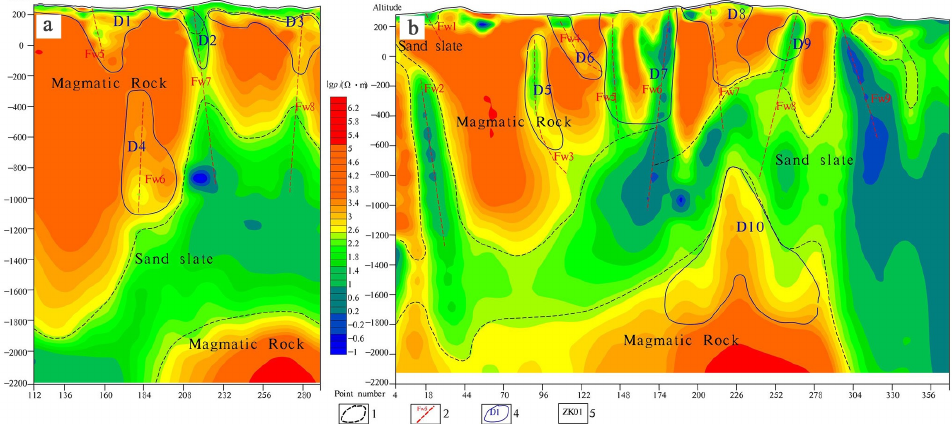
Figure 5. ( a ) 111 line profile inference diagram; ( b ) 191 line profile inference map.